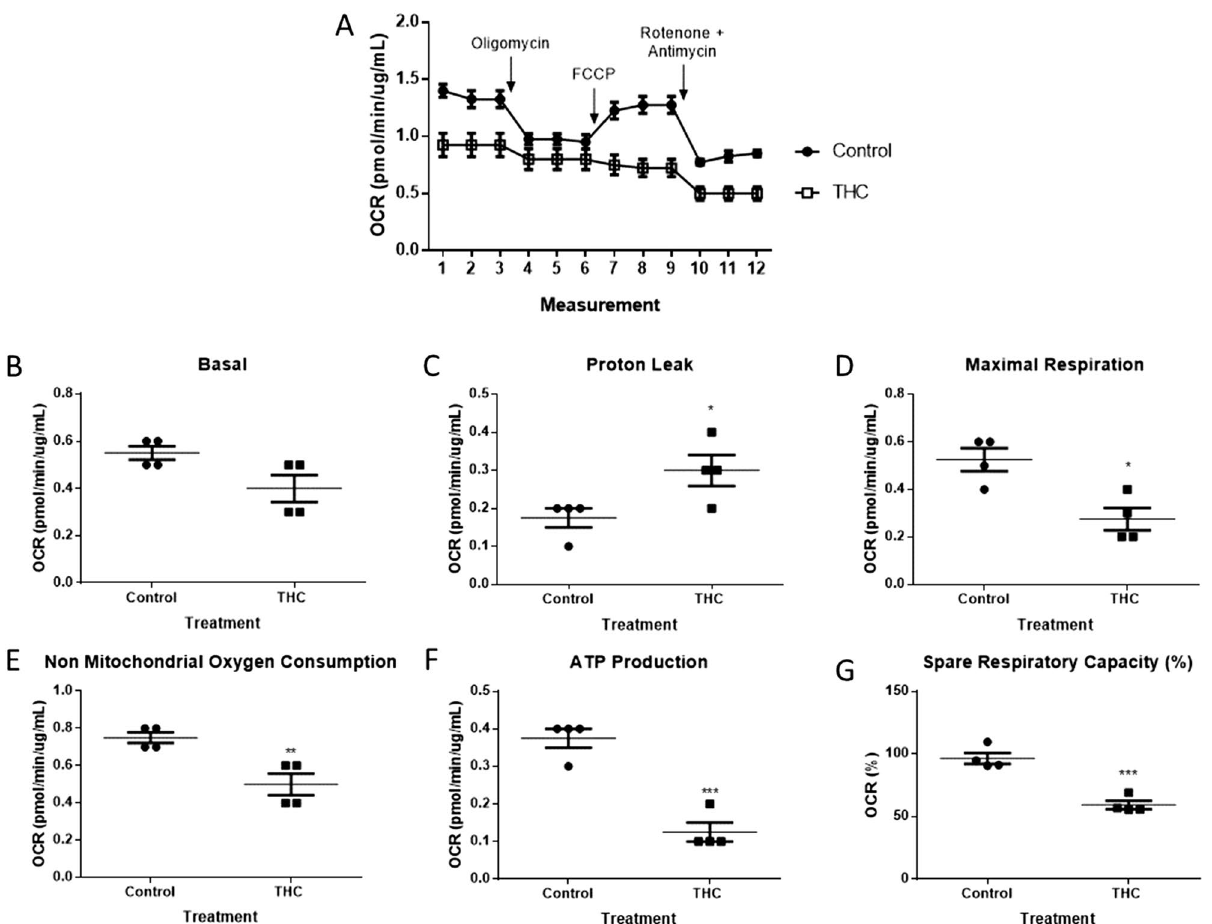
Figure 8. Mitochondrial respiration indices are impaired in HTR8/SVneo cells upon 48-h exposure to 20 µM THC. (A) Representative OCR tracing. (B–G) Mitochondrial parameters as indicated. The detection of OCR was performed with 4 biological replicates per experiment, for each treatment condition, and repeated 3 more times (see Supplemental Fig. 2 for experiments 2–4). Individual data (B–G) , group mean and SEM (A–G) are shown. Significance was assessed by Student’s t-test (* P < 0.05, ** P < 0.01, *** P <